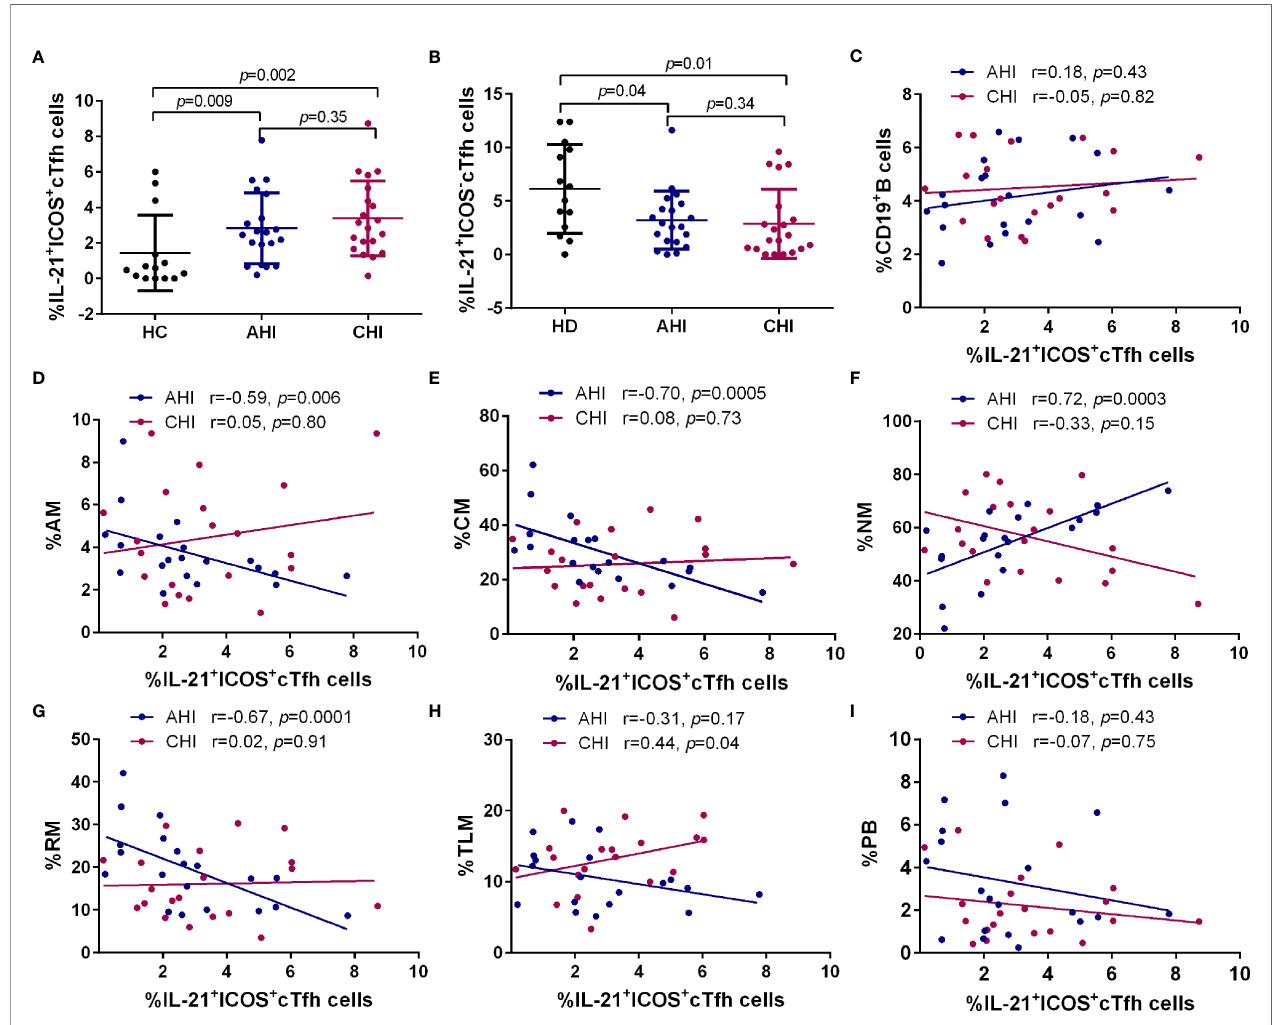
FIGURE 4 | Correlation between the frequencies of B cell subsets and IL-21 + ICOS + cTfh cells in the AHI and CHI groups. PBMCs from HC (n=13), AHI (n=20) and CHI (n=20) were stimulated with leukocyte activation cocktail for 6 h in vitro and the frequency of IL-21 + ICOS + cTfh cells (A) or IL-21 + ICOS - cTfh cells (B) was measured by fl ow cytometry. All data shown are means ± SD. (C – I) . Correlation analysis of the IL-21 + ICOS + cTfh cell frequency with bulk B cells, AM, CM, NM, RM, TLM, and PB in the AHI and CHI